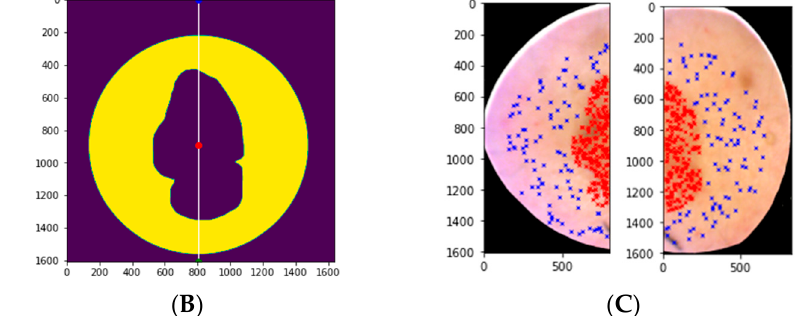
Figure 4. The ground truth with the image sliced through the middle (white line); training data on the left and test data on the right ( A ). The healthy skin mask ( B ). The training and test data. Blue represents the healthy skin pixels; red represents the lesion pixels ( C ). The size of the original lesion annotation was minimized to a lesion binary map of 30 pixels and similarly enlarged to a healthy skin mask. A 60-pixel margin at the lesion border was applied where no pixels were selected.